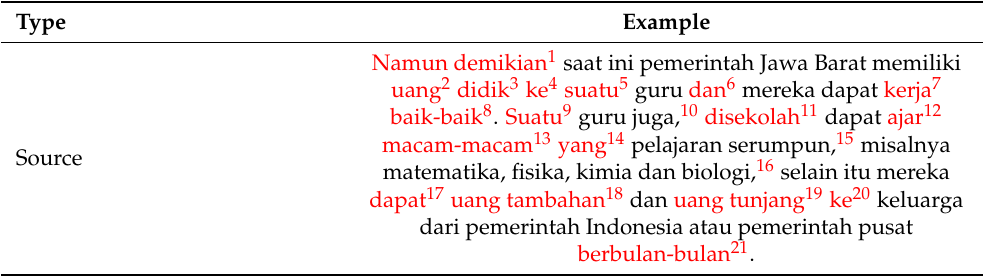
Table 5. Performance of different versions of our model, where the incorrect words have been numbered and colored in